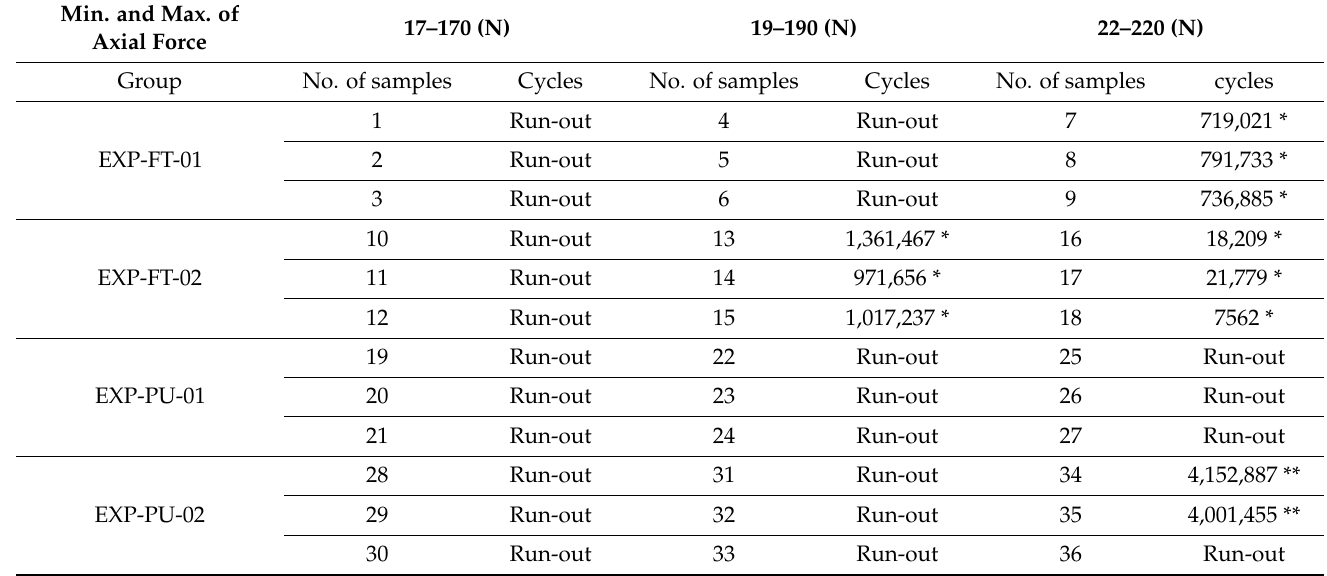
Table 3. Results of the dynamic compression bending test.